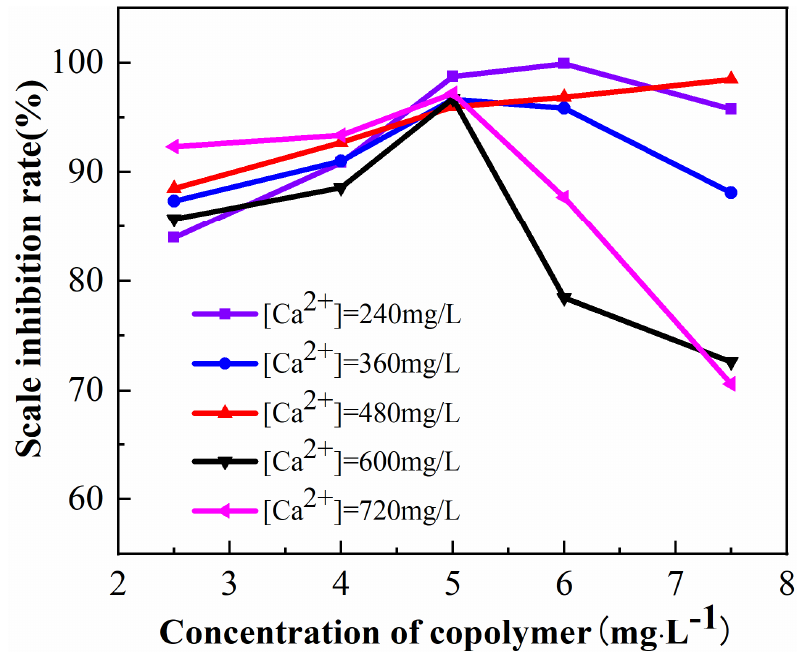
Figure 4. Influence of Ca 2+ dosage on scale inhibition performance .